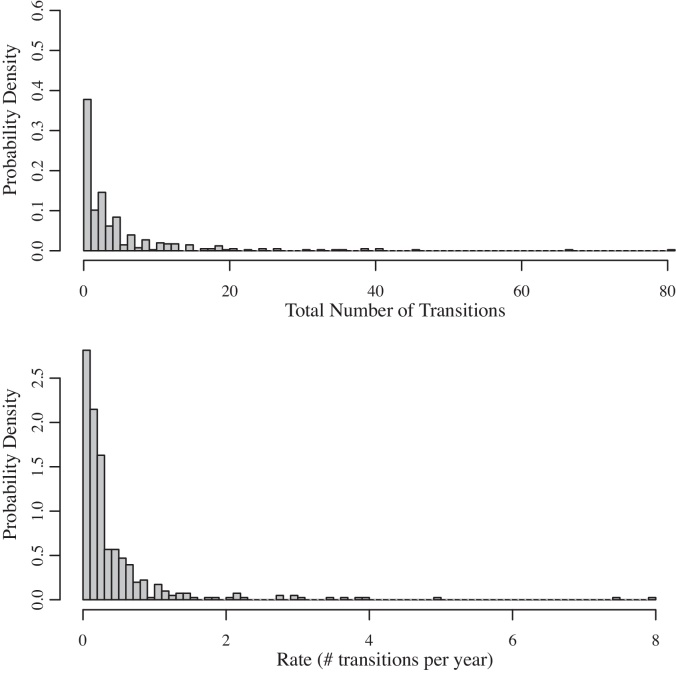
Histograms of the total number and rate of transitions for the 405 PWID in the EAC, United Kingdom, 1980–2006.